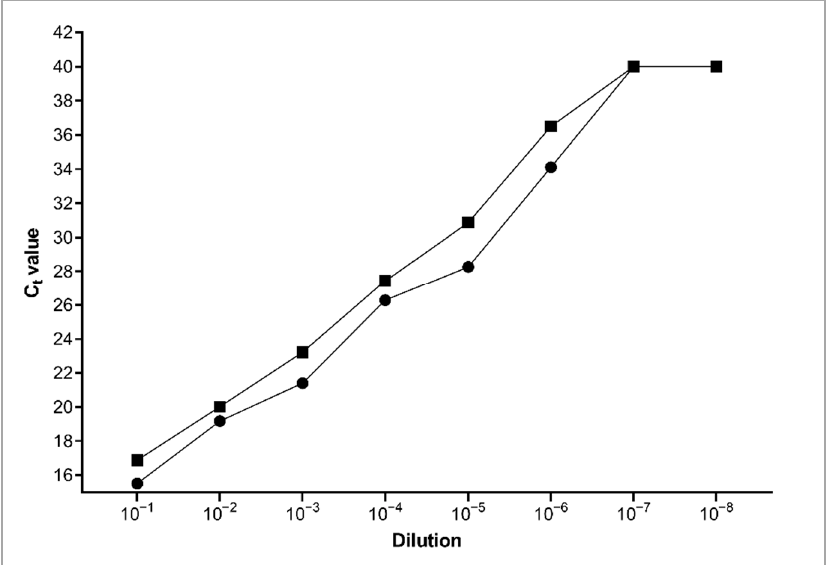
Figure 3. C t values obtained for serial dilutions of Mycobacterium avium subspecies paratuberculosis in caprine colostrum after DNA extraction using the ADIAPURE PARATB MILK kit and the ADIAVET PARATB REAL TIME PCR kit (Adiagene, Bio-X Diagnostics S.A., Rochefort, Belgium). Trial 1 ( ) and trial 2 ( ).